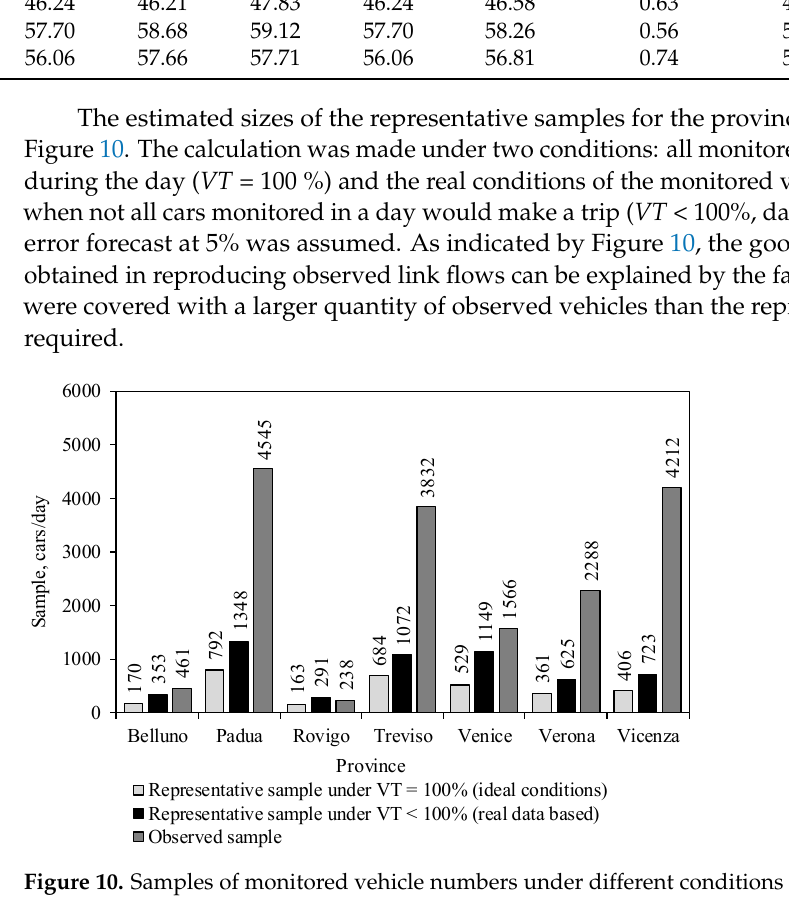
Table 8. Data on VT values for the observation days.